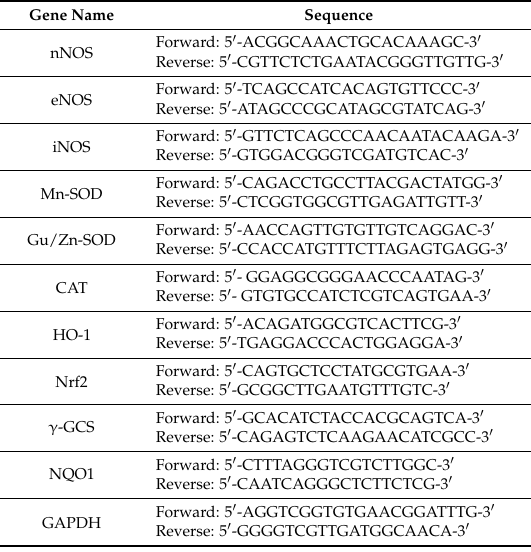
Table 5. Sequences of qPCR primers used in this